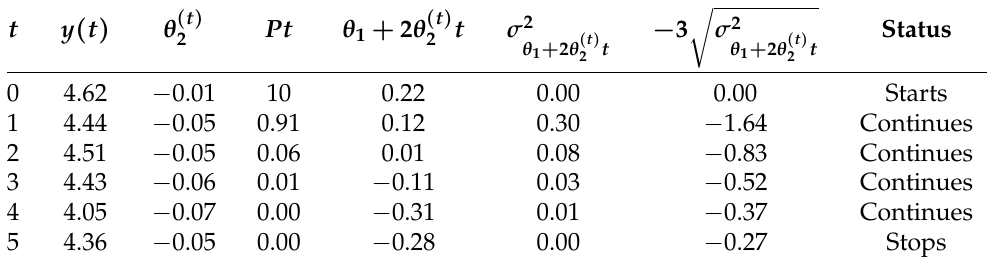
Table 4. Obtained results of the RPR procedure in Case 1.